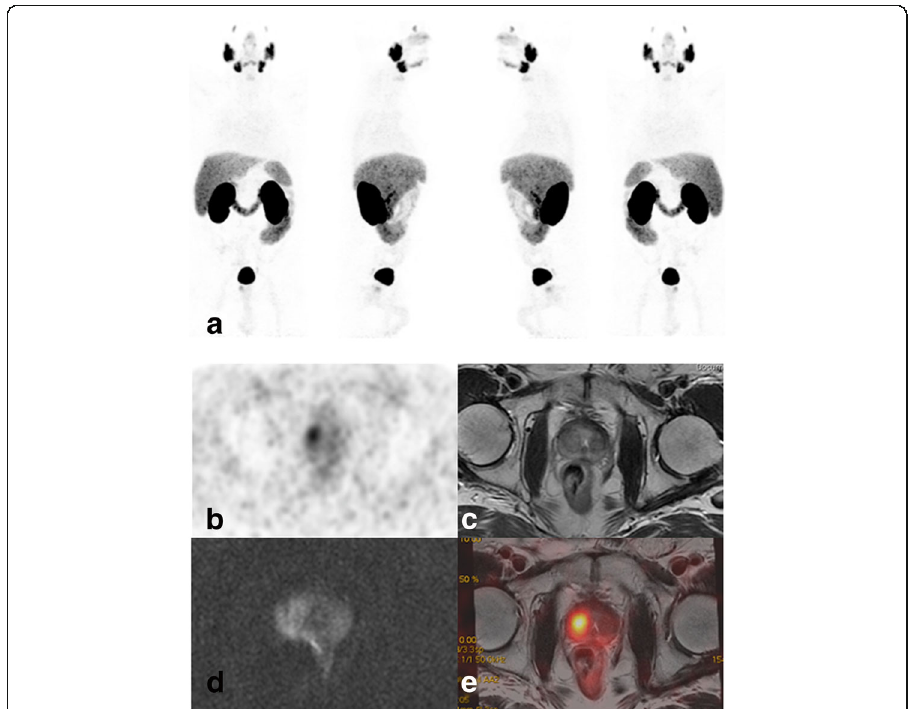
Fig. 4 Patient 2. A 61-year-old-patient treated with radiotherapy and hormonotherapy with PSA relapse (PSA level 10 ng/ml). MIP and axial 68 Ga-PSMA PET ( a - b ), high-resolution T2 ( c ), DWI ( d ) and PET/MR images ( e ) demonstrating a coincident local relapse. DWI shows peripheral diffusion restriction that partially overlaps the lesion seen in T2 and perfectly matches PSMA